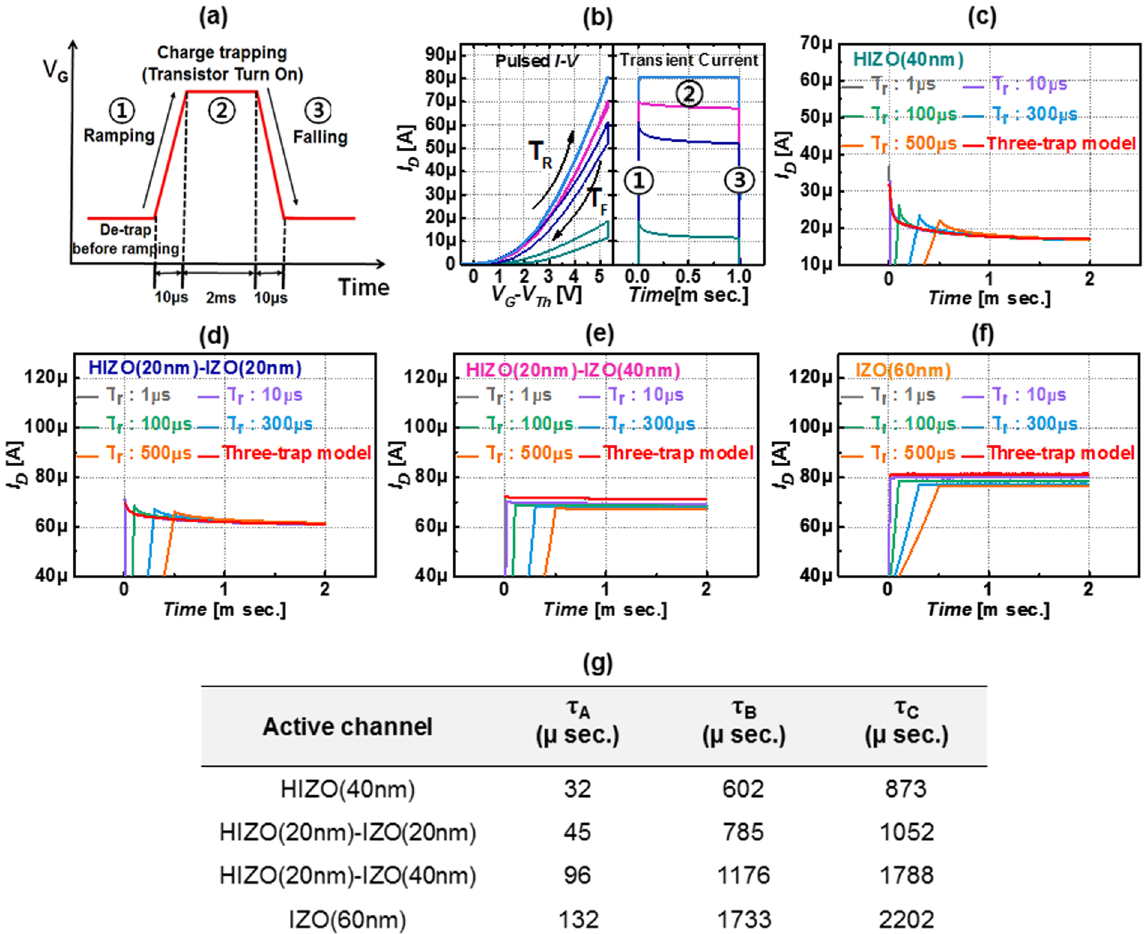
Figure 3. ( a ) Voltage ramp profile of single pulse measurements (rising time = falling time = 10 μ s and pulse width = 2 ms). ( b ) (Left figure) Single pulse I–V data and (right figure) corresponding transient current versus time data for four oxide TFTs. ( c – f ) Transient current data of HIZO (40 nm), HIZO (20 nm)-IZO (20 nm), HIZO (20 nm)-IZO (40 nm) and IZO (60 nm) as a function of rising time and fitted using the three-trap model. ( g ) Charge trapping time constant extracted from the fitting curve the multiple-trapping